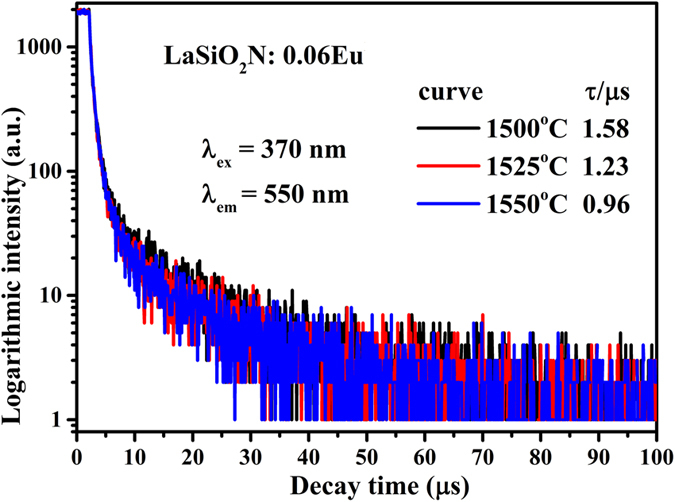
The decay curves of LaSiO2N:0.06Eu prepared at 1500 °C, 1525 °C, and 1550 °C, respectively.